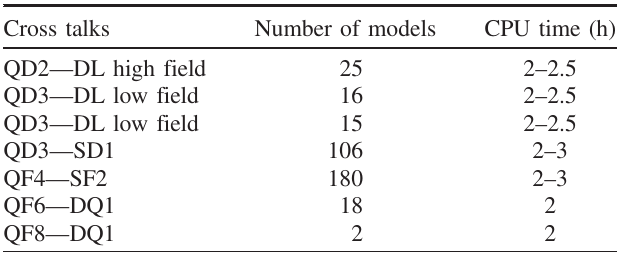
TABLE III. Number of 3D models of magnet pairs solved and approximated computation time for each of them, for one